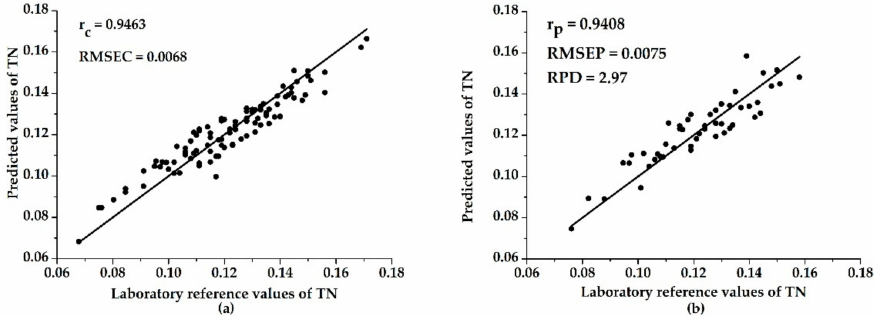
Figure 6. The scatter plots of the calibration set ( a ) and the prediction set ( b ) in the UVE–ELM model.